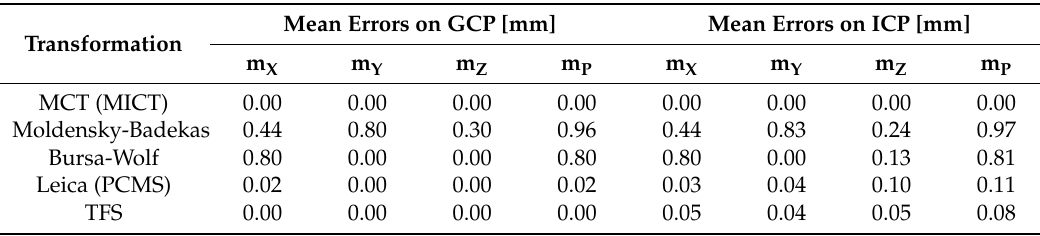
Table 13. Mean errors of transformations (standard deviation) for laboratory data set without distortion by random errors.